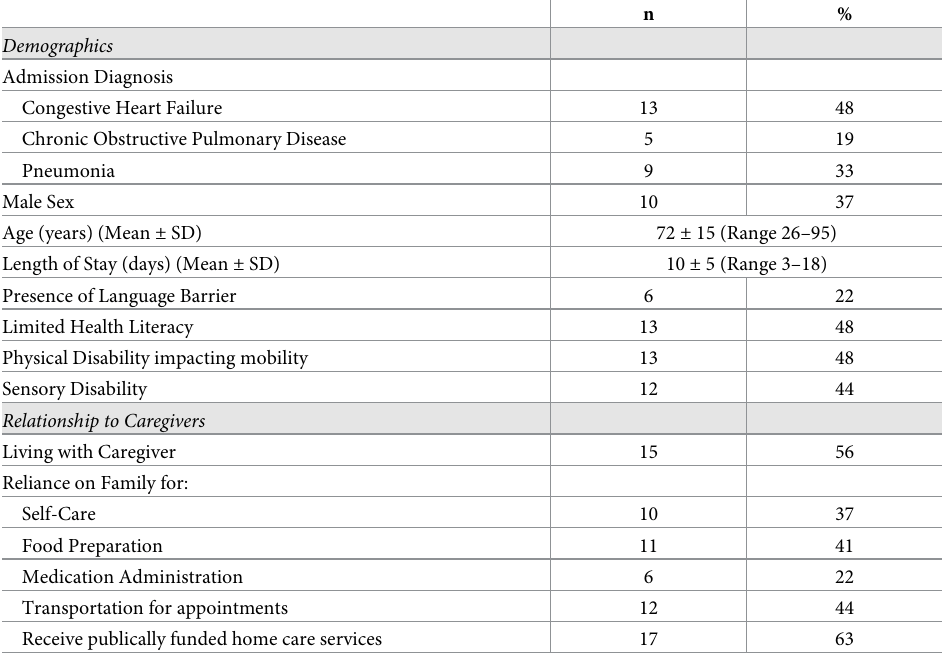
Table 2. Baseline characteristics of the interview population (n =